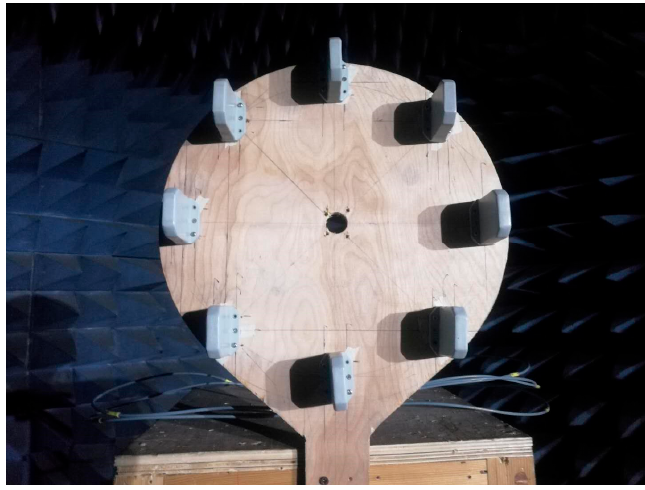
Figure 5. Measured UCA with a radius 0.15 m and 8 log periodic dipole antennas.